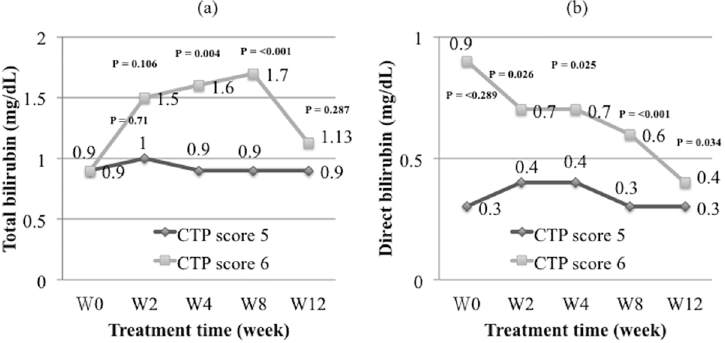
Fig 3. (a) Total bilirubin elevation during the treatment. (b) Direct form bilirubin elevation during the